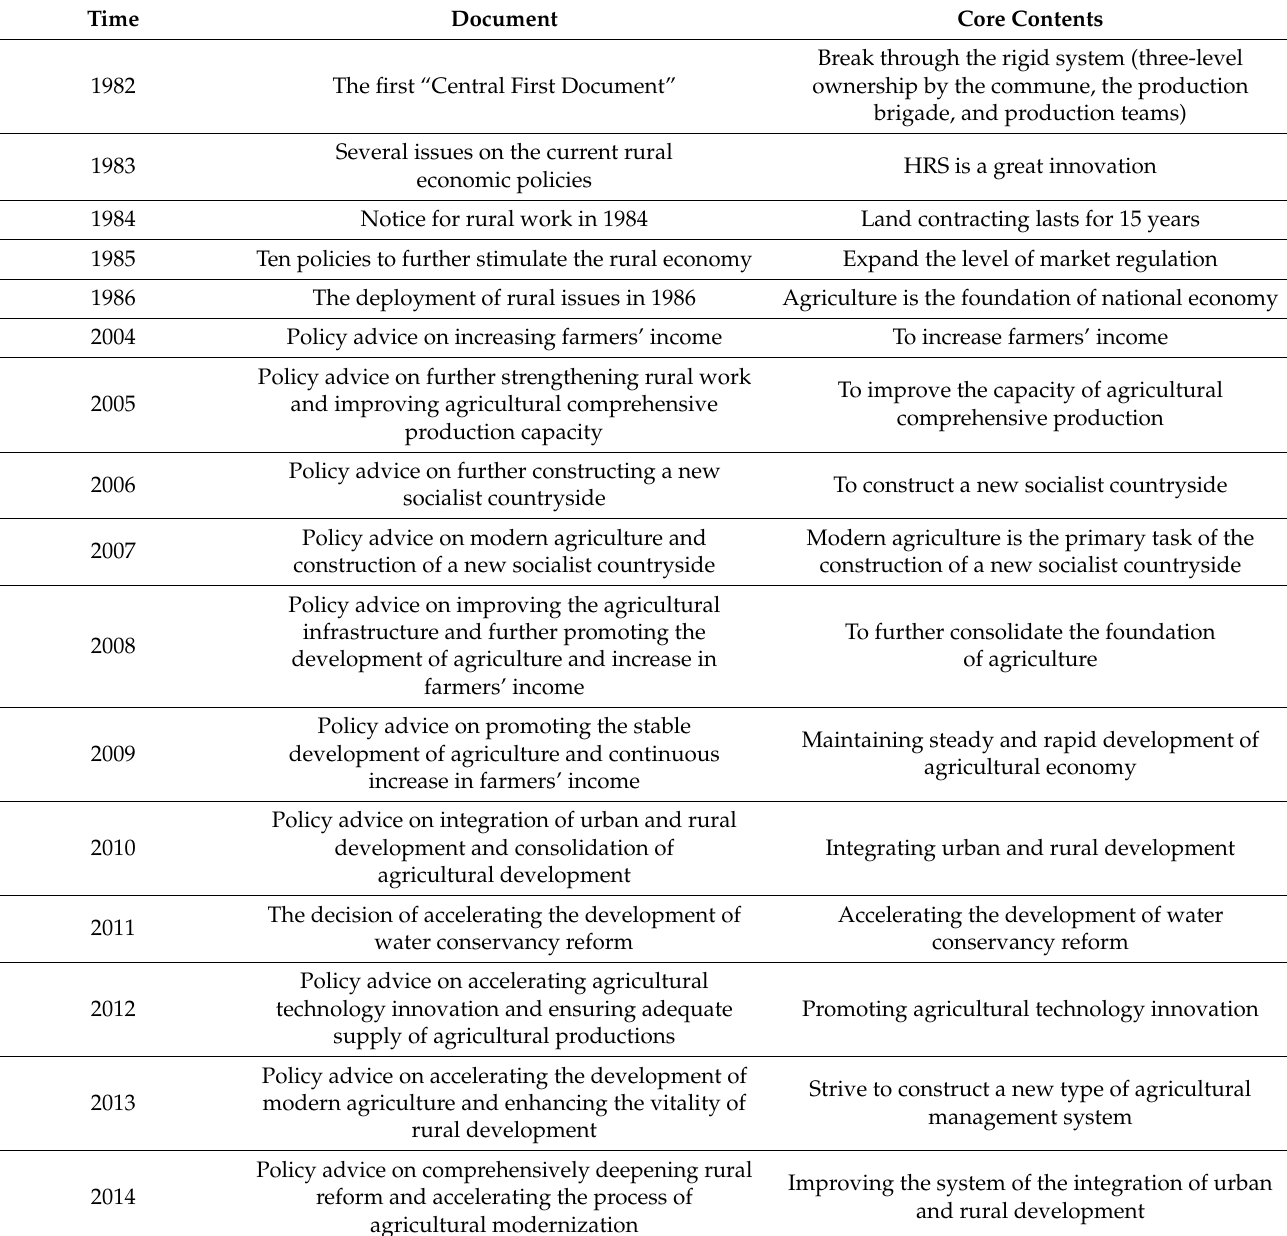
Table 5. Rural issues-related central first